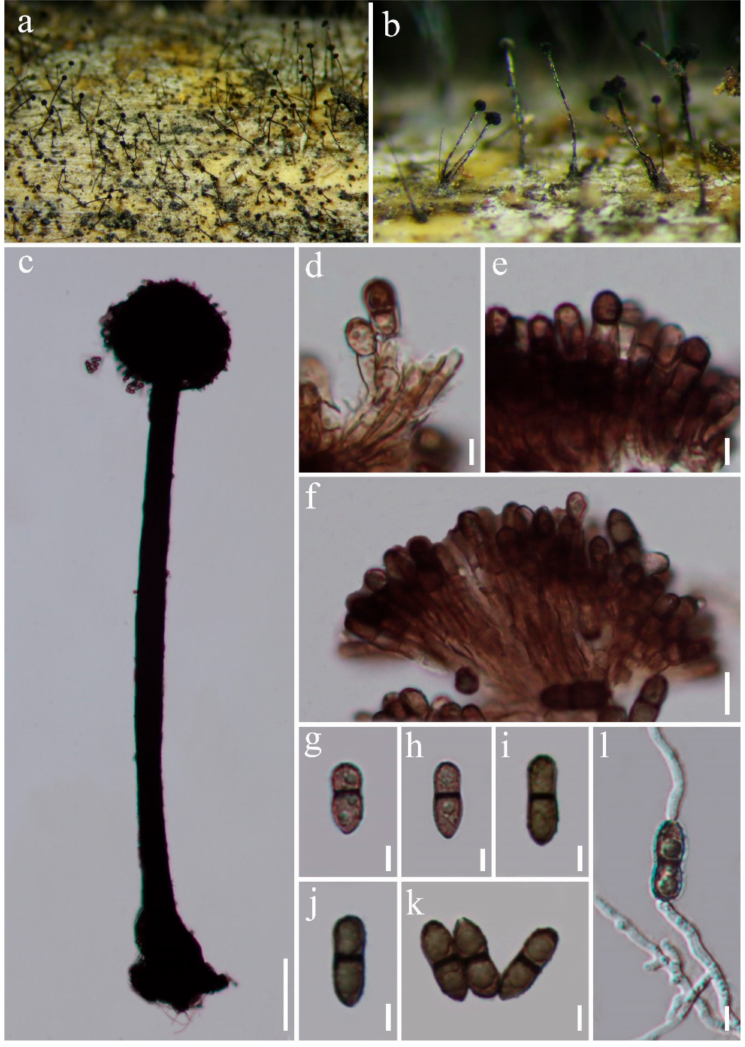
Figure 5. Vamsapriya uniseptata (GZAAS:21-0378, holotype) ( a , b ) Colonies on natural substrate. ( c ) Conidiophores and conidia. ( d – f ) Conidiogenous cells and developing conidia. ( g – k ) Conidia. ( l ) Germinated conidium. Scale bars: c = 100 µ m, d , e , g , h = 5 µ m, f = 10 µ